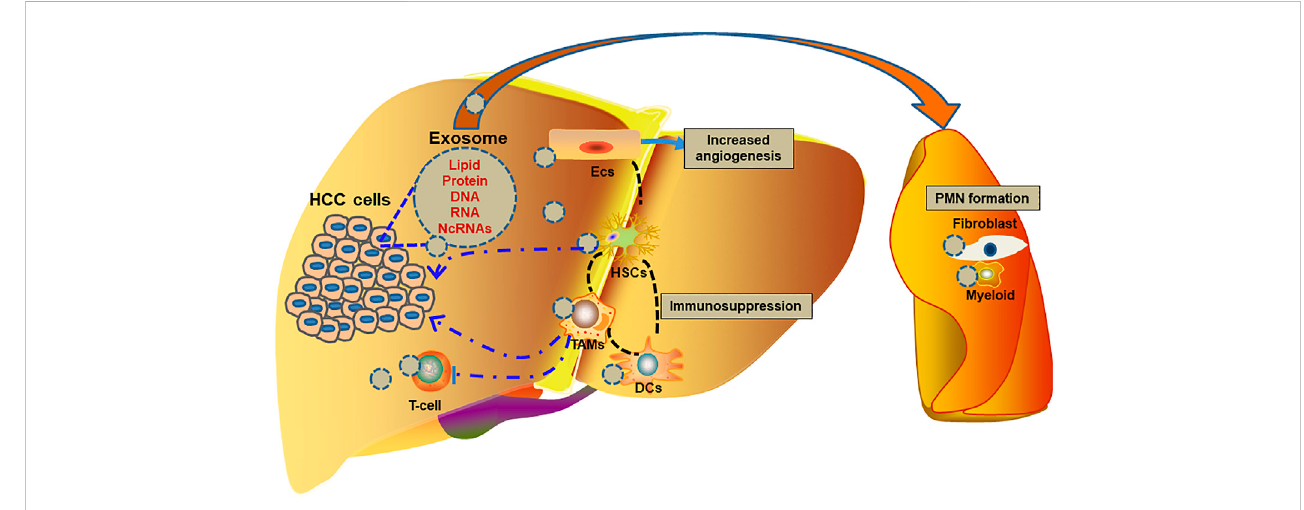
Role of exosomes in the progression of